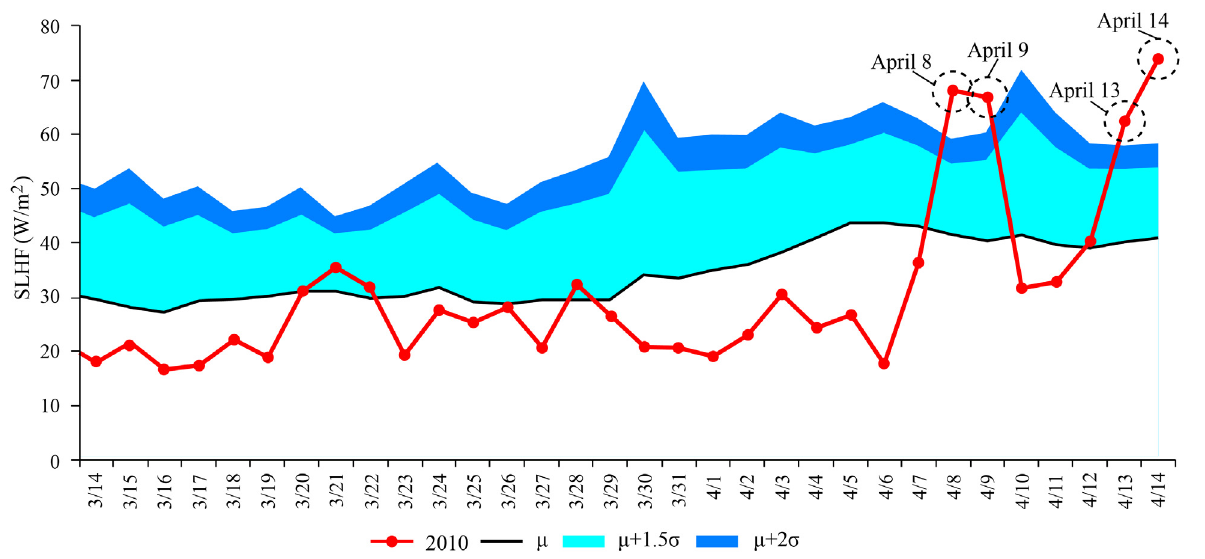
Figure 6. Time series of SLHF data on the epicenter pixel from March 14 to April 14 2010, and its comparison with historical data over the same period. The red line is the SLHF variation curve of 2010, the black line is the mean ( µ ) variation curve on the same day during the non- shock years (1979-2009), the cyan and blue zone is the multi-year mean value plus 1.5 times and twice the standard deviation ( v ), and the ar- rows indicate the earthquake